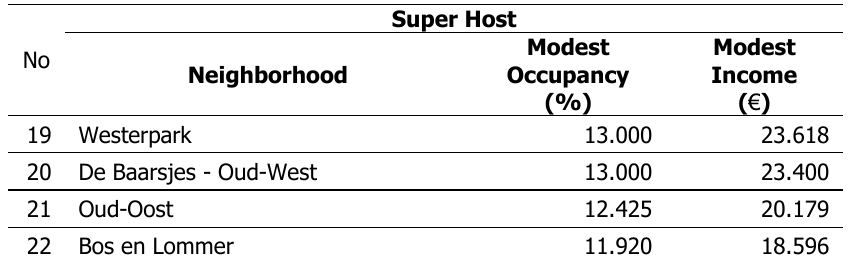
Table 4 . Regular Host Monthly Occupancy Rate And Yearly Income By District No Neighborhood